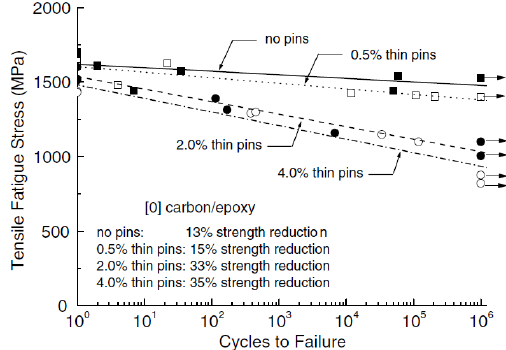
F igure 41. S-N curve for a z-Pinned F igure 42. S-N curve for z-Pinned Figure 41. S-N curve for a z-Pinned composite subjected to cyclic tension-tension (CFRP z-Pins, d = 0.28 mm, [0] pre-preg) [1].